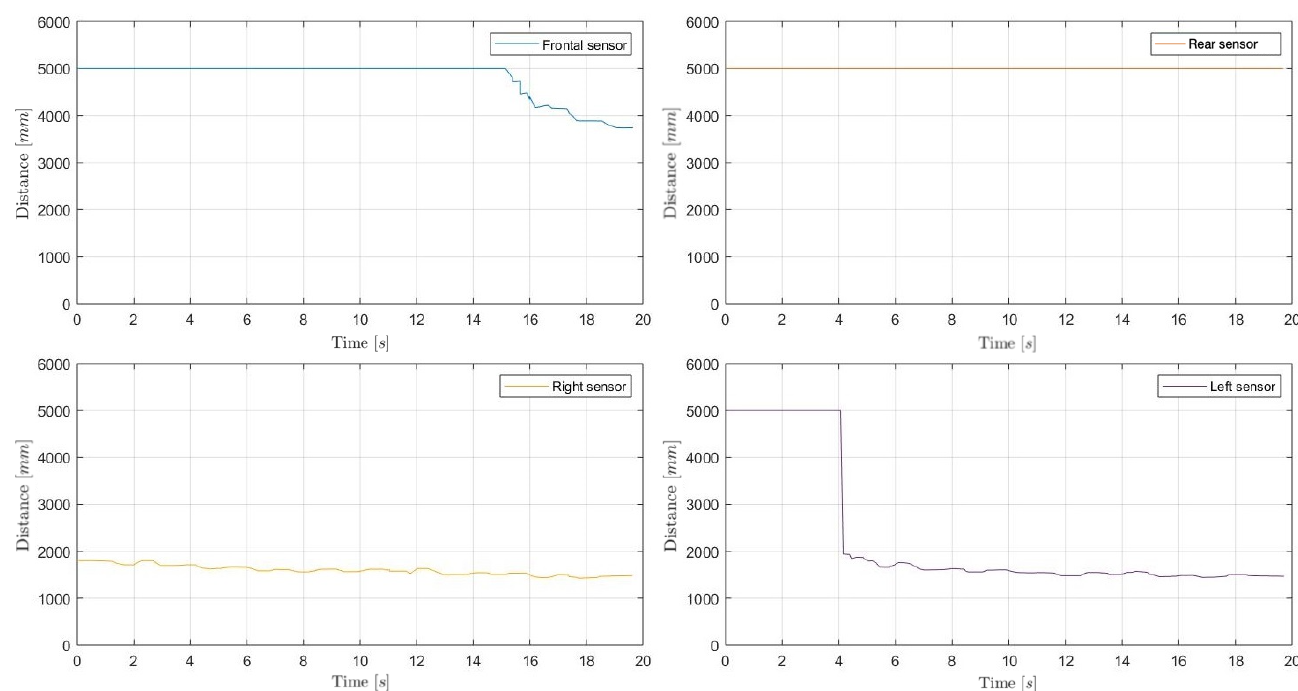
Figure 10. Distance estimates detected with the ultrasonic sensors’ configuration shown in Figure 8, during a walk in the middle of the house backyard.